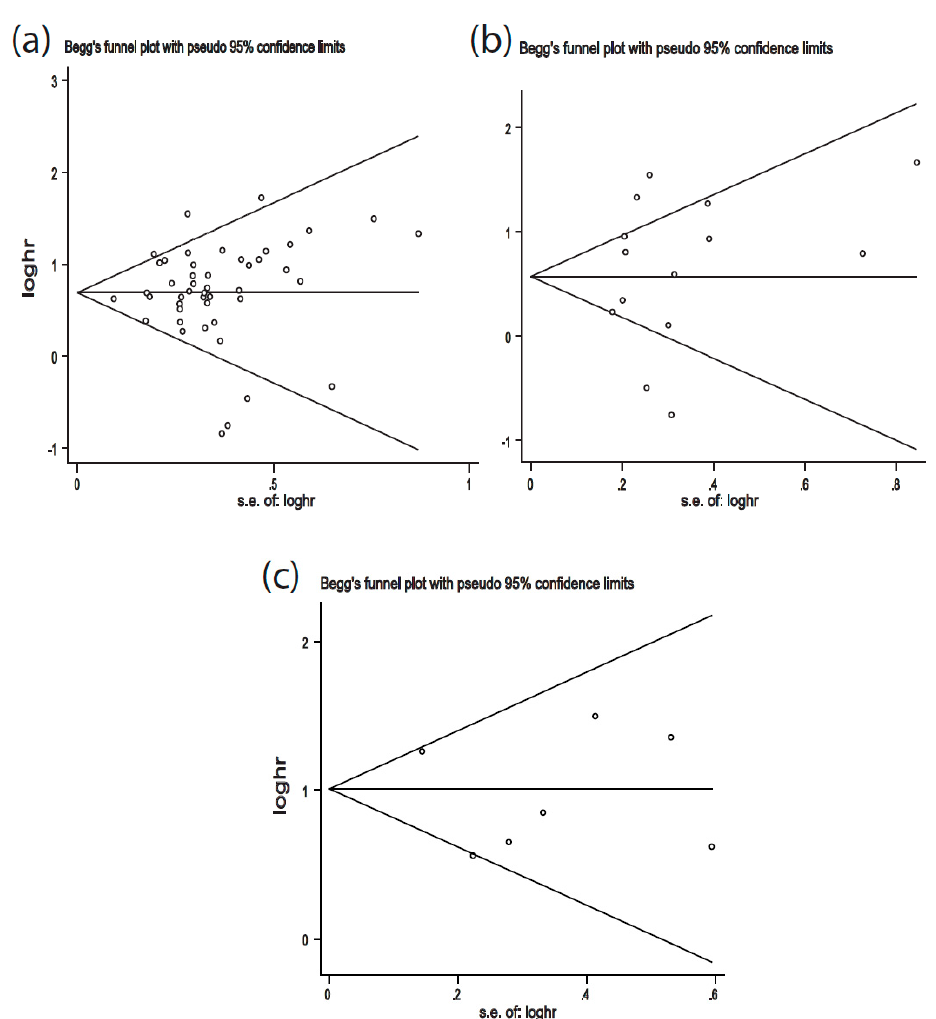
Figure 4. Begg’s funnel plots of publication bias. ( a ) Begg’s funnel plot of publication bias for OS; ( b ) Begg’s funnel plot of publication bias for RFS/DFS; ( c ) Begg’s funnel plot of publication bias for MFS/PFS. Each circle represents a separate study.